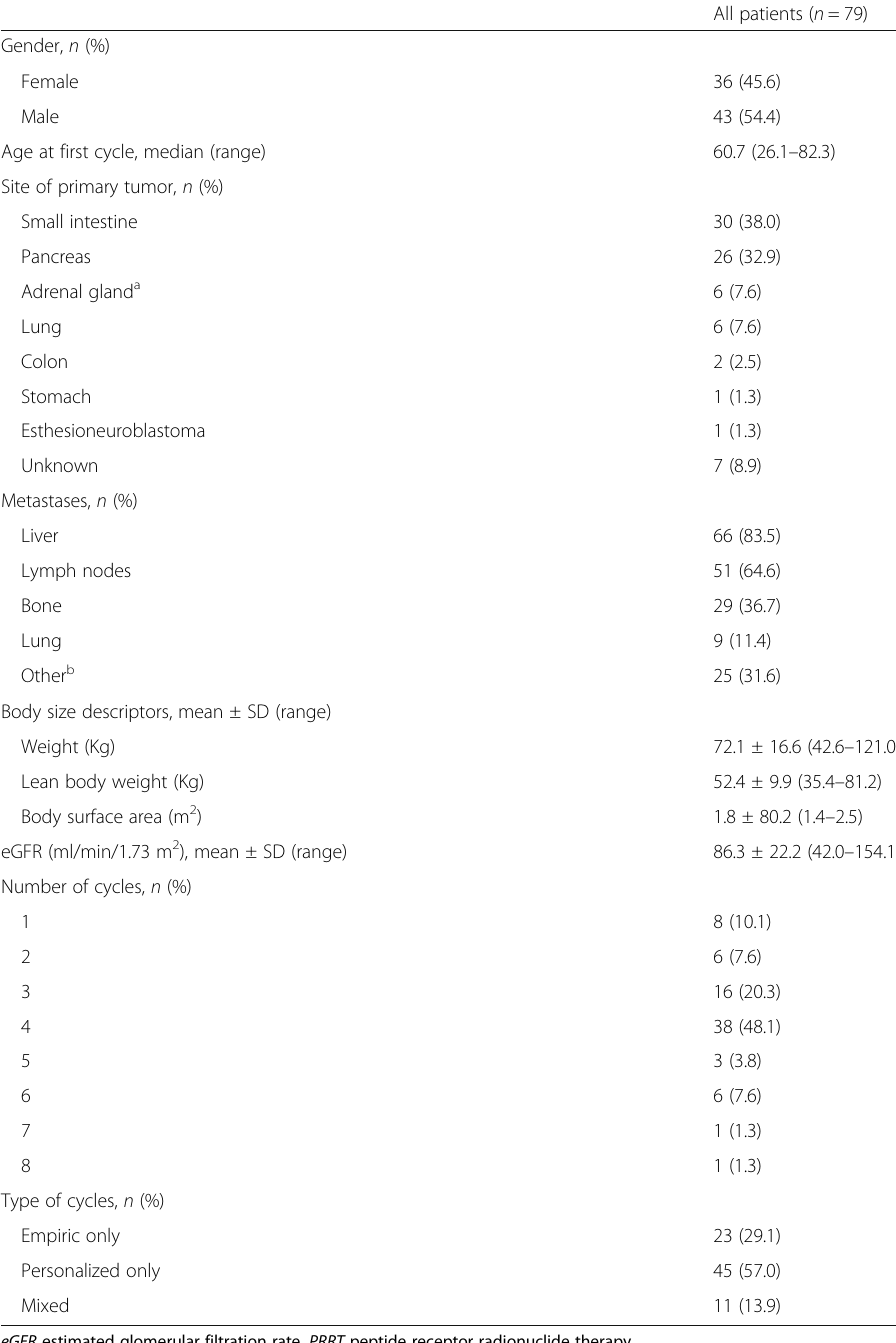
Table 1 Patient